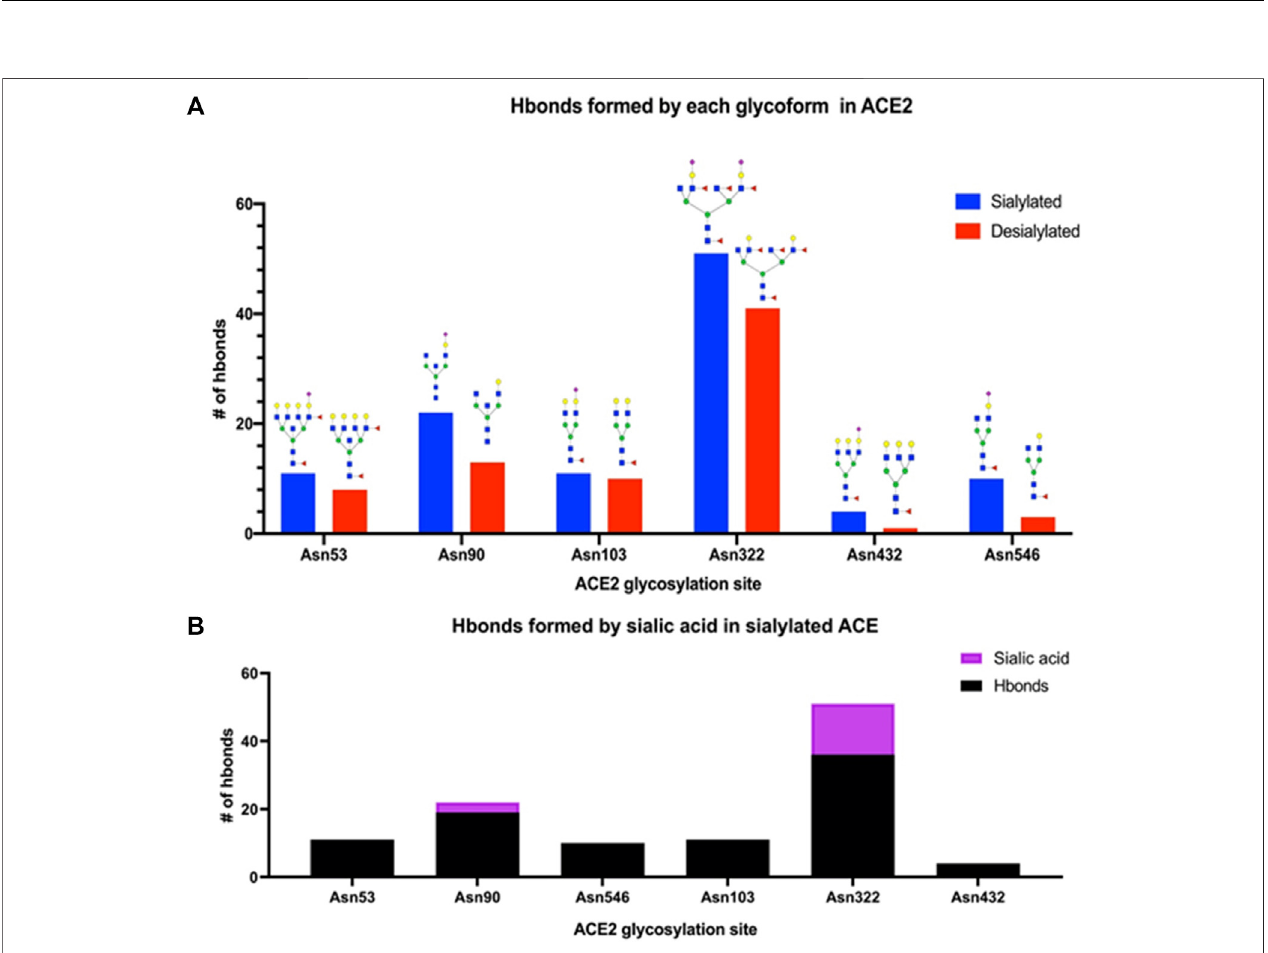
FIGURE 9 | Interactions of glycosylated ACE2 and S-protein were revealed using molecular dynamics simulations. (A) The number of intramolecular hydrogen bonds was drastically higher for each fully-sialylated N-glycan compared to the desialylated glycoform. (B) For Asn 90 and Asn 322, the sialic acid residue in the glycoform accounted for ~10% of hydrogen